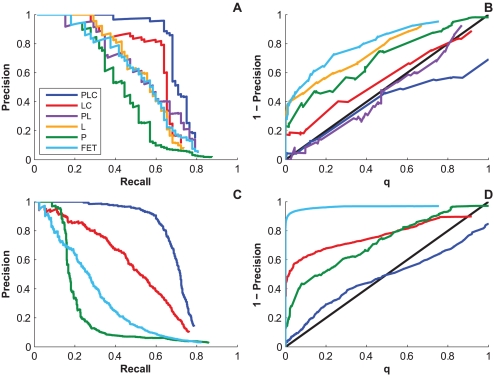
Performance on data generated from the 97% clade B HOMER cohort.Precision-recall (A) and calibration curves (B) of the models with respect to HLA-codon associations; precision-recall (C) and calibration curves (D) of the models with respect to both HLA-codon and codon-codon associations. Better precision-recall curves are ones that tend toward the upper right of the plot. Curves with perfect calibration follow the diagonal.